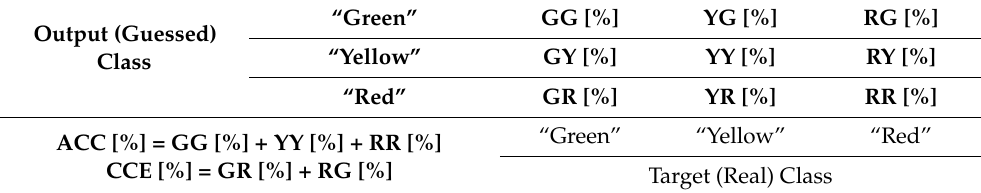
Table 1. Uniform confusion matrix structure used in the article (additional explanations in the text).